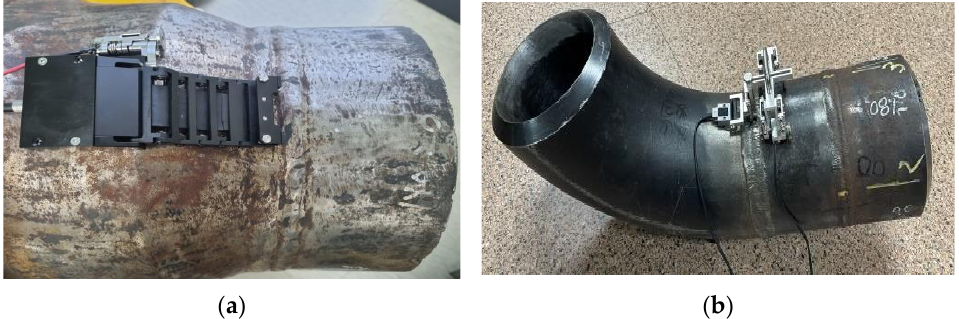
Figure 16. Semi-automatic scanner employed an actual specimen: ( a ) scanner with FPAPr and encoder attached; ( b ) scanner with PA probe and encoder attached.